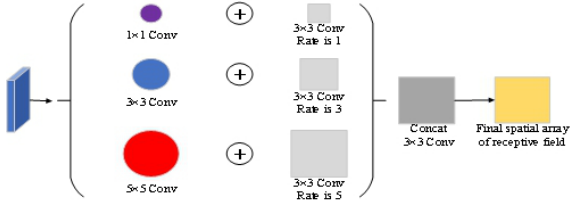
Fig. 5. Multi-scale information fusion process.